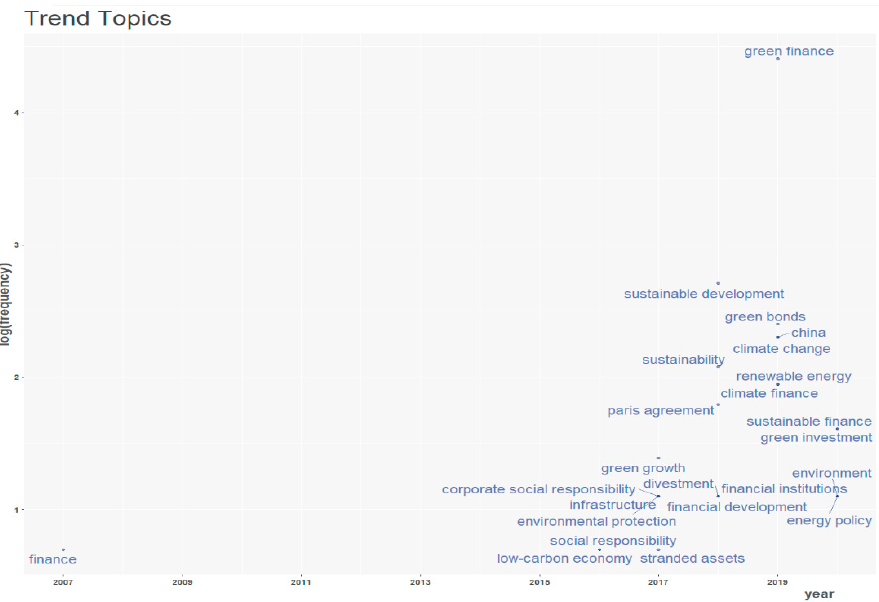
Figure 7. Trends of the topic in the journal (line 317).